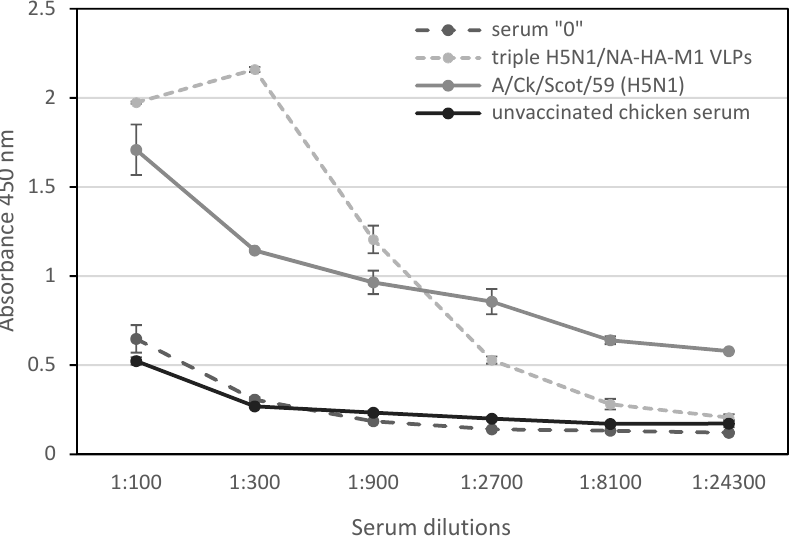
Figure 4. End-point titration of chicken sera after immunization with triple H5N1/NA-HA-M1 VLPs. ELISA plates were coated with reference antigen inactivated H5N1 virus. Serial dilutions of chicken A/H5N1/HPAI polyclonal antibodies served as a positive control. Chicken serum from day 0 and control chicken serum served as a background. The dilution factor of the pooled sera is shown on the x-axis. For each ELISA, the mean value from three independent experiments performed is presented. The mean A450 values and standard deviations are shown on the y-axis.